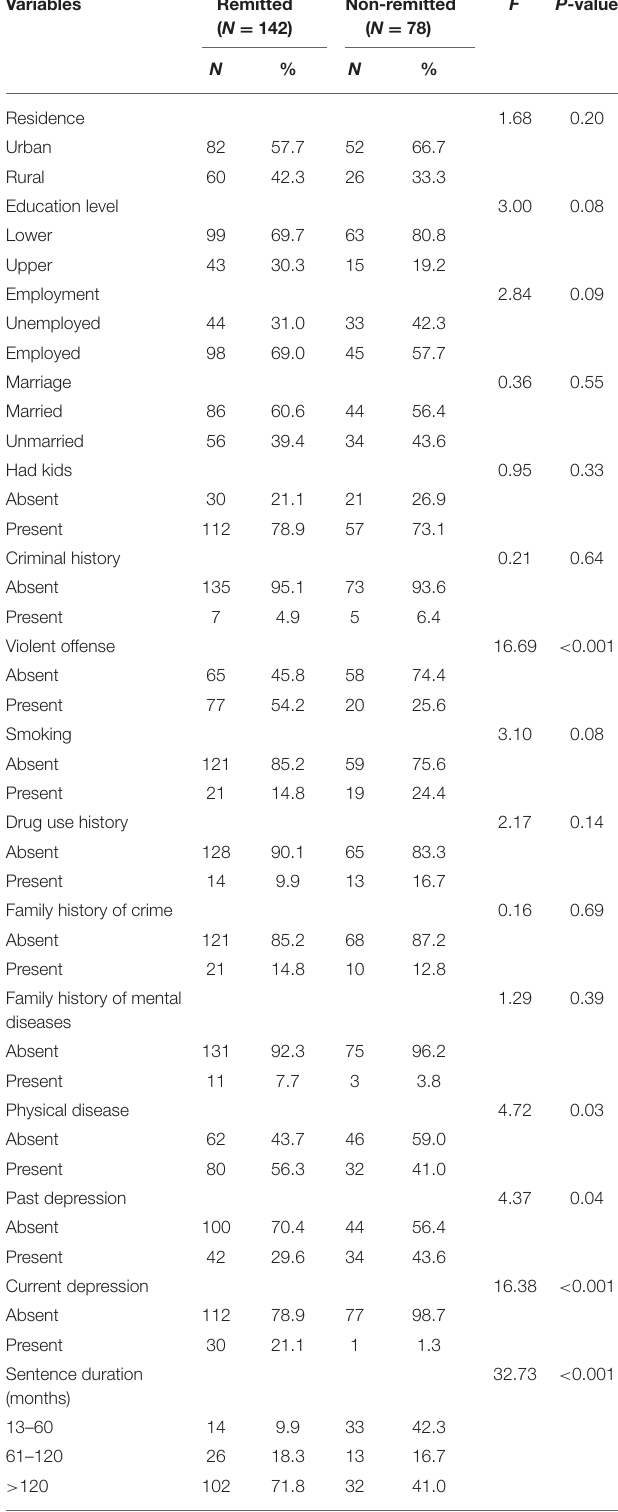
TABLE 3 | Comparison between naturally remitted PTSD and non-remitted PTSD among incarcerated women. Variables Remitted Non-remitted ( N = 142) ( N =